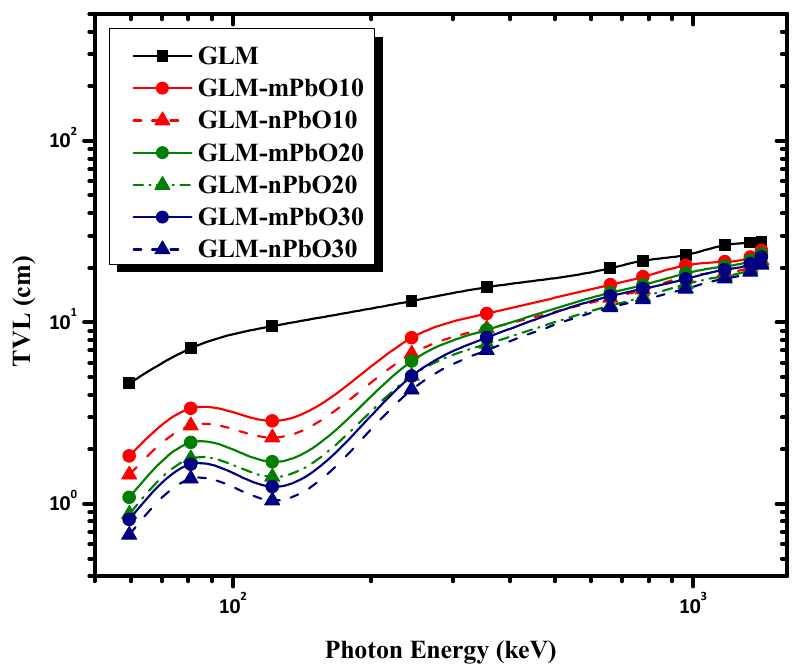
Figure 6. The variation of TVL as a function of photon energy for micro- and nano-PbO mortars.